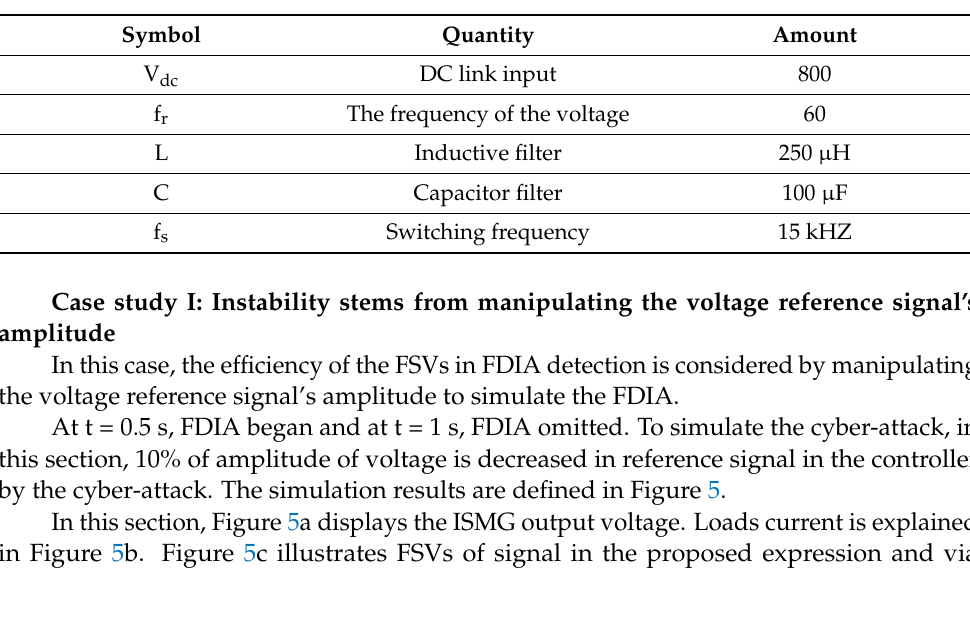
Table 2. DG units’